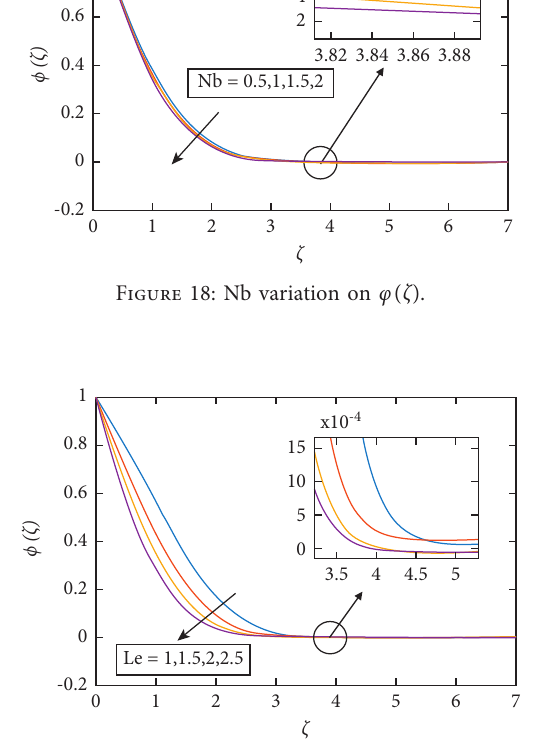
Figure 19: Le variation on φ ( ζ ) .